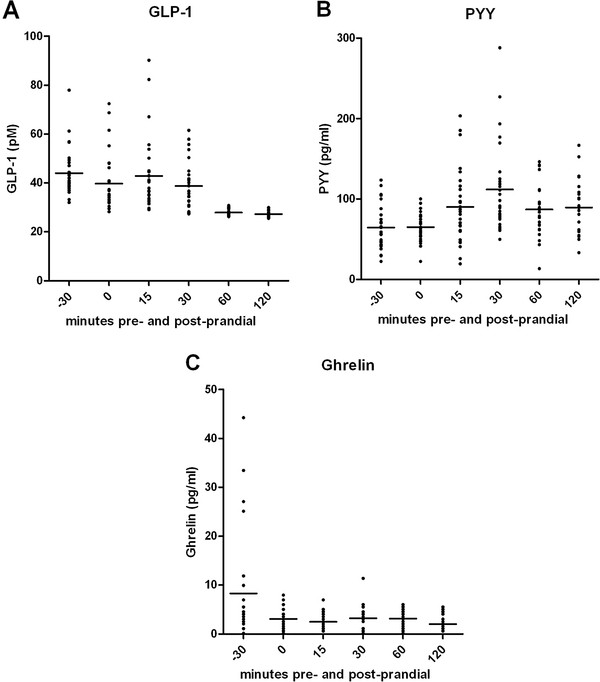
Distributions of pre- and post-prandial gut hormone levels. The horizontal lines in each figure are means.